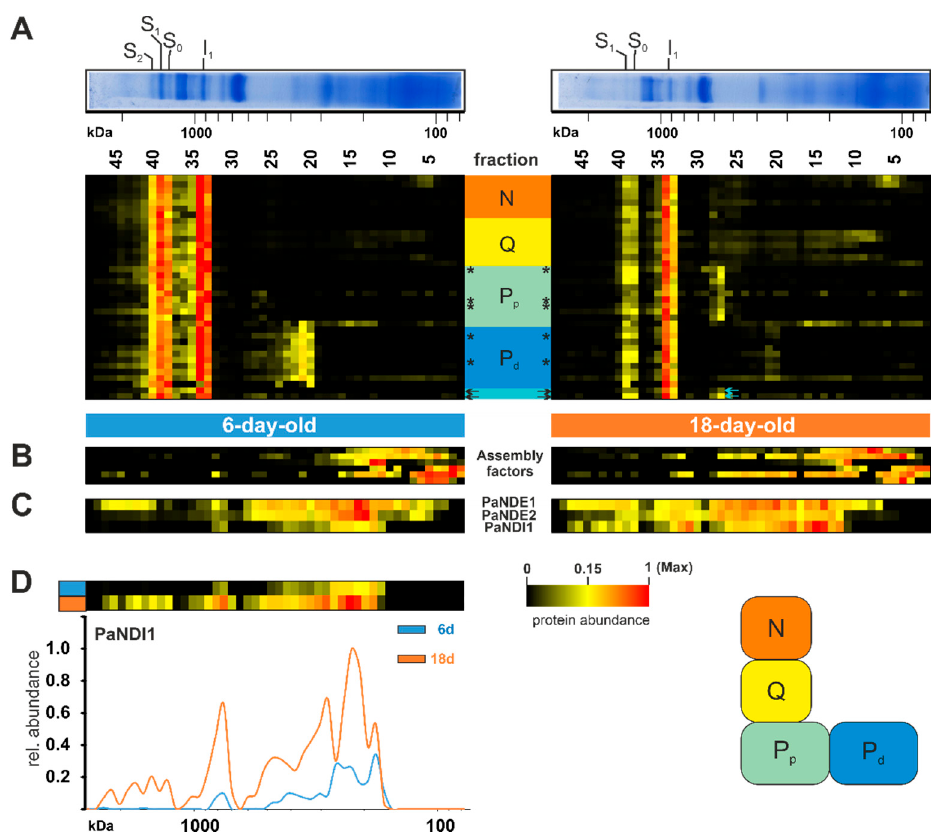
Figure 3. Increase of alternative NADH dehydrogenase PaNDI1 during aging. ( A ) Quantified proteins of complex I, assignment to modules, complex I assembly factors, ( B ) homologs of complex I assembly factors and ( C ) the alternative NADH dehydrogenases PaNDI1 (Pa_7_1820), PaNDE1 (Pa_1_24200) and PaNDE2 (Pa_7_5390) are represented in heat maps. Mitochondrial-encoded proteins are marked by asterisks (*). Complex I modules were assigned according to [80] N-module (N) in orange, Q-module (Q) in yellow, proximal proton pumping module (Pp) in light green, distal proton pumping module (Pd) in blue. Two unassigned subunits marked in light cyan. The color scale of heatmaps ranges from black (not identified), to yellow (15% of the maximum), to red (maximum abundance). ( D ) Distribution profiles of PaNDI1 in 6-day-old (grey line) and 18-day-old (orange line) wild-type mitochondria. For detailed information about the corresponding proteins refer to Table